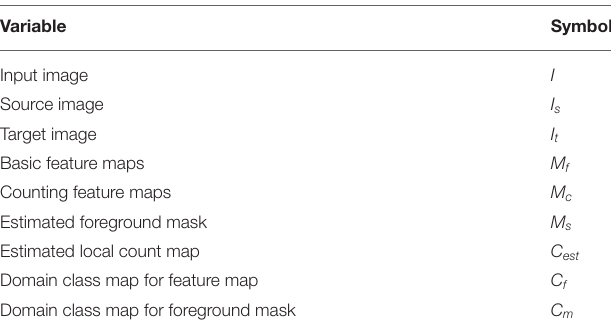
TABLE 1 | Definition of variables.